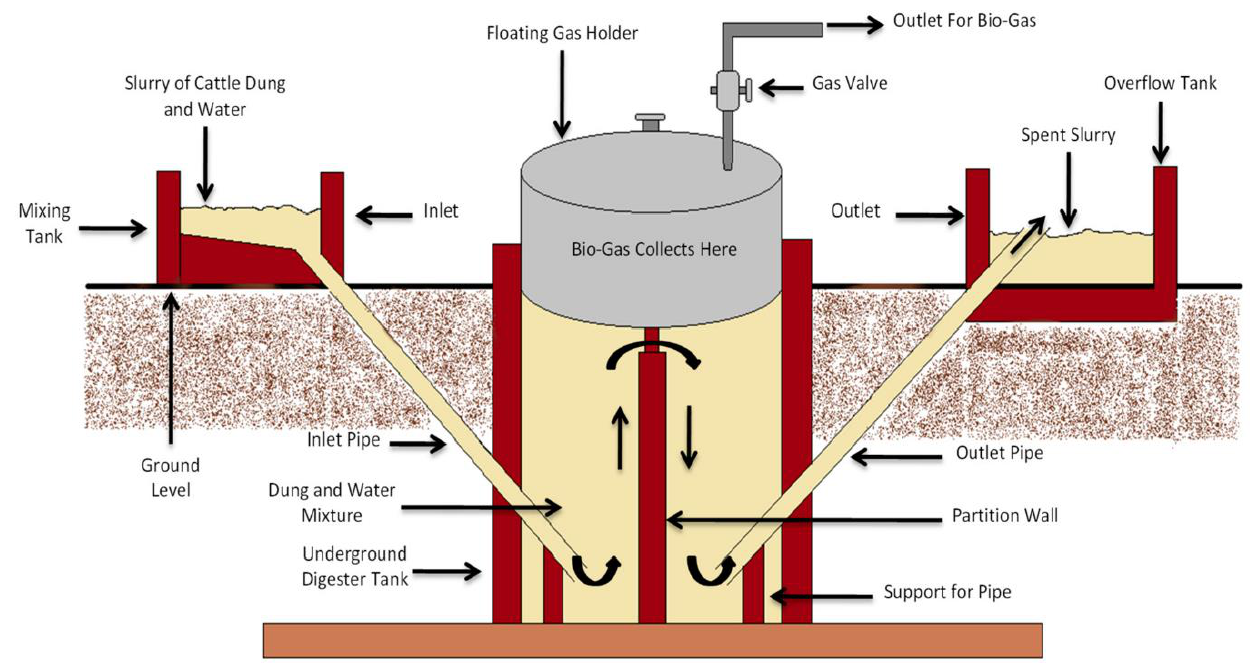
Figure 12. Schematic representation of the typical floating-drum biogas plant. This diagram is adapted from the work of Prachi Pandey et al. Reused under Creative Commons license [71] .